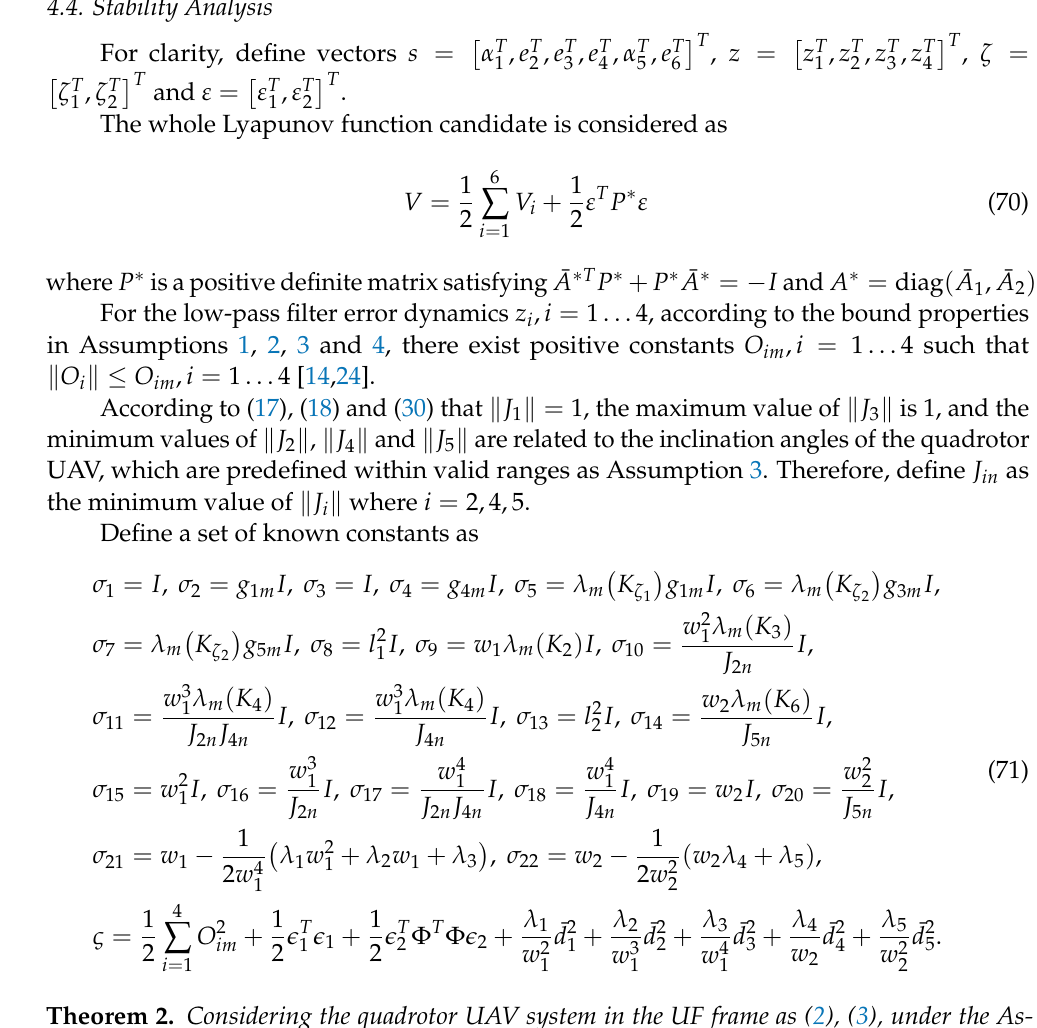
Figure 3. The block diagram of the proposed control